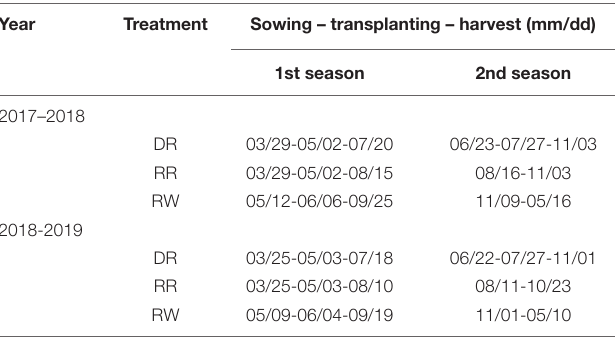
TABLE 2 | Date of sowing, transplanting, and harvest for the three cropping